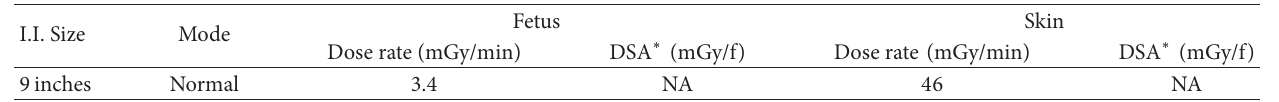
Table 2: Simulated results of radiation exposure with the Siemens Siremobil Compact C-arm in the operating suite. I.I. Size